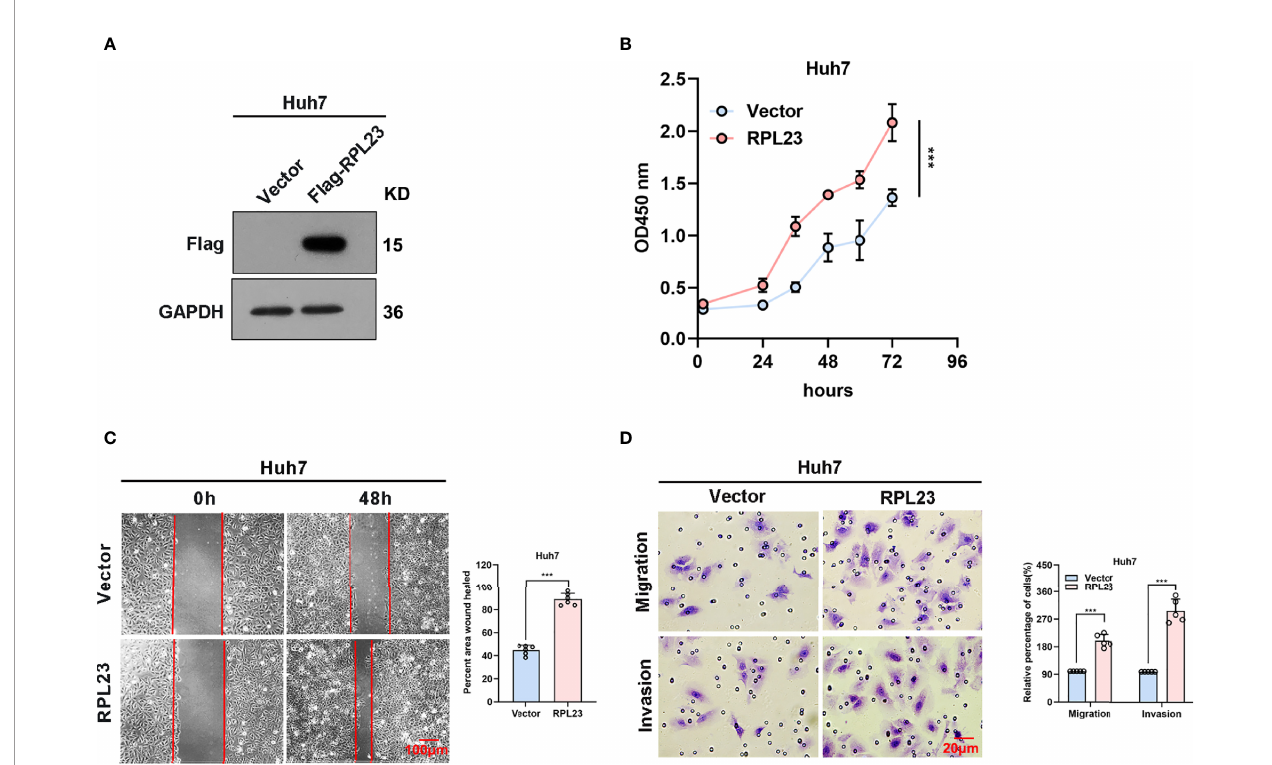
FIGURE 4 | Overexpression of RPL23 promoted HCC cell proliferation, invasion and migration in vitro . (A) The overexpression ef fi ciency of RPL23 was tested by western blotting analysis in Huh7 cells. GAPDH was used as a reference gene. (B) CCK-8 assay was applied to evaluate proliferation ability of Huh7 cells with expression of RPL23. (C) Migratory ability of overexpression RPL23 was detected by wound-healing assay in Huh7 cells. The cells were counted from 6 images. (D) Migratory and invasive ability were assessed by transwell assays in Huh7 cells with RPL23 overexpression. The cells were counted from 5 images. Representative data are from at least three independent experiments. Data are shown as mean ± SD. ***P <